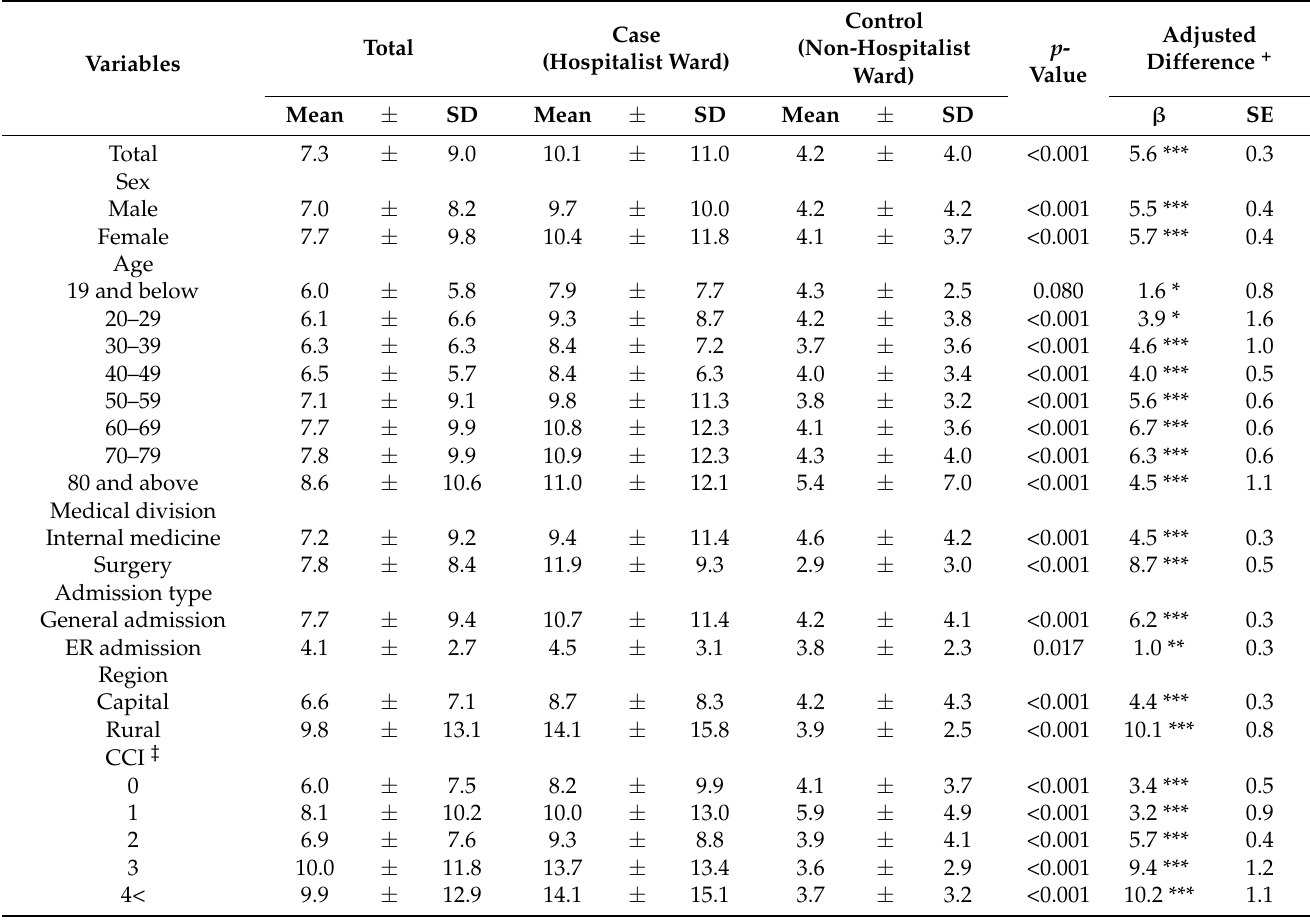
Table 1. General characteristics of the frequency of patient–doctor contact during the hospital stays and results of regression analysis +